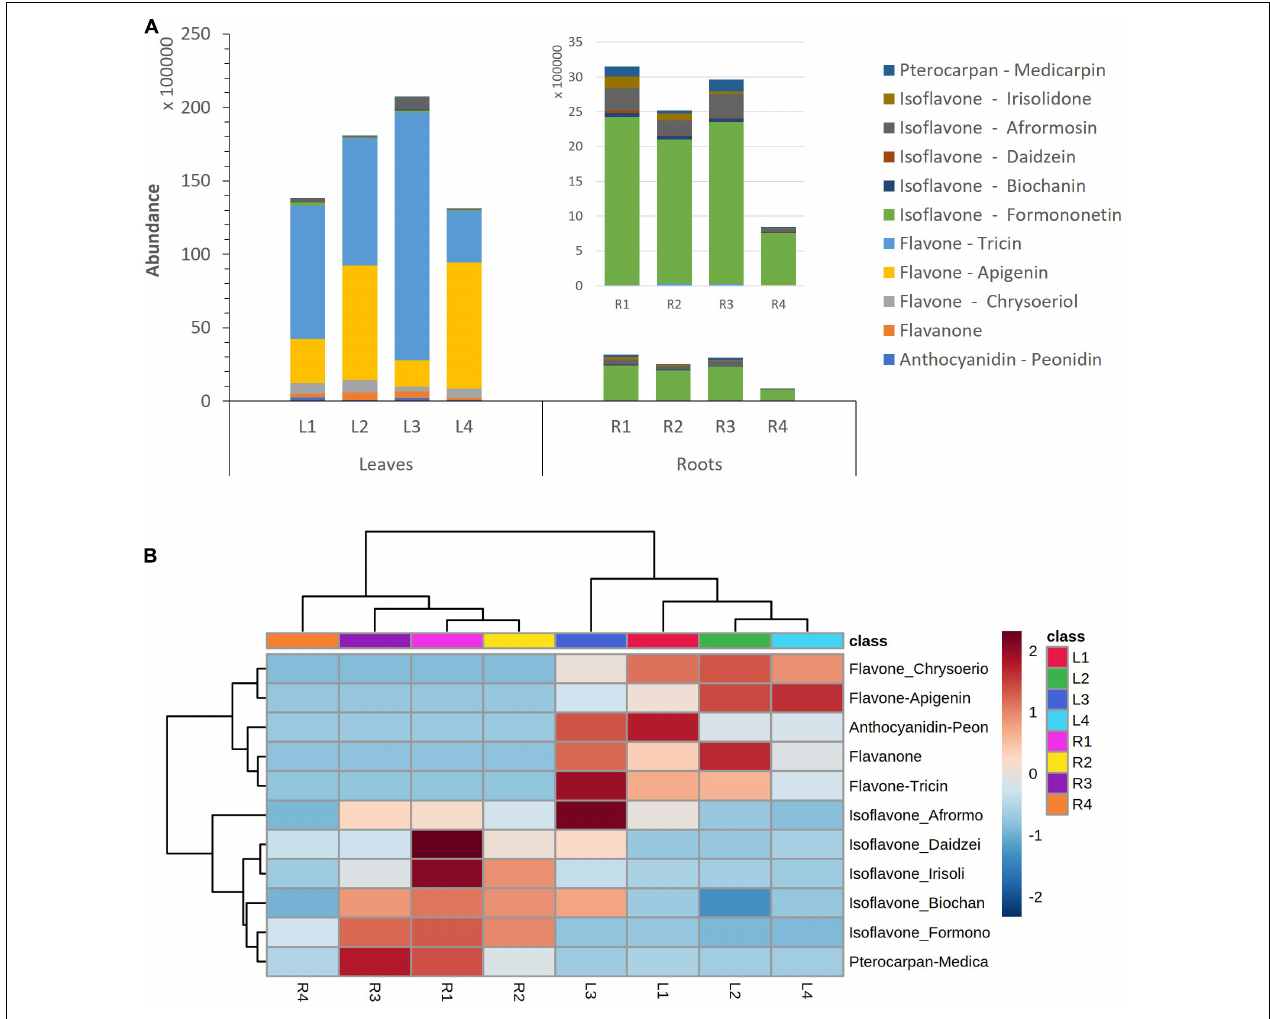
FIGURE 2 | (A) Accumulation of flavonoid families in Medicago truncatula leaves and roots. (B) Dendrogram and heatmap of flavonoid families in M. truncatula leaves (L) and roots